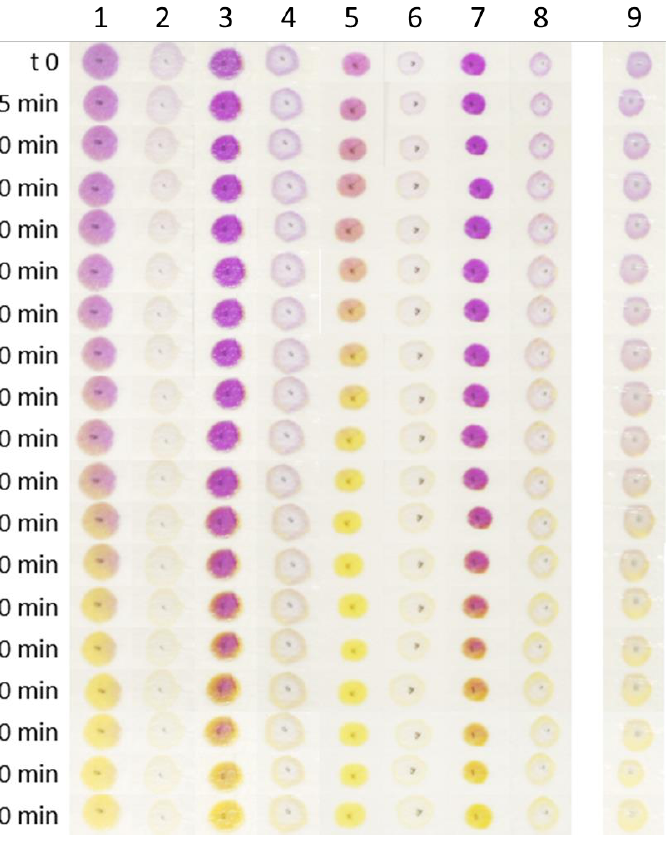
Figure 4. Pictures acquired during detection of acidic volatile analytes originated from 100 mL AcOH 0.01 M in a sealed box (V = 1.75 L) for each of the 8 + 1 sensors of the experimental plan.